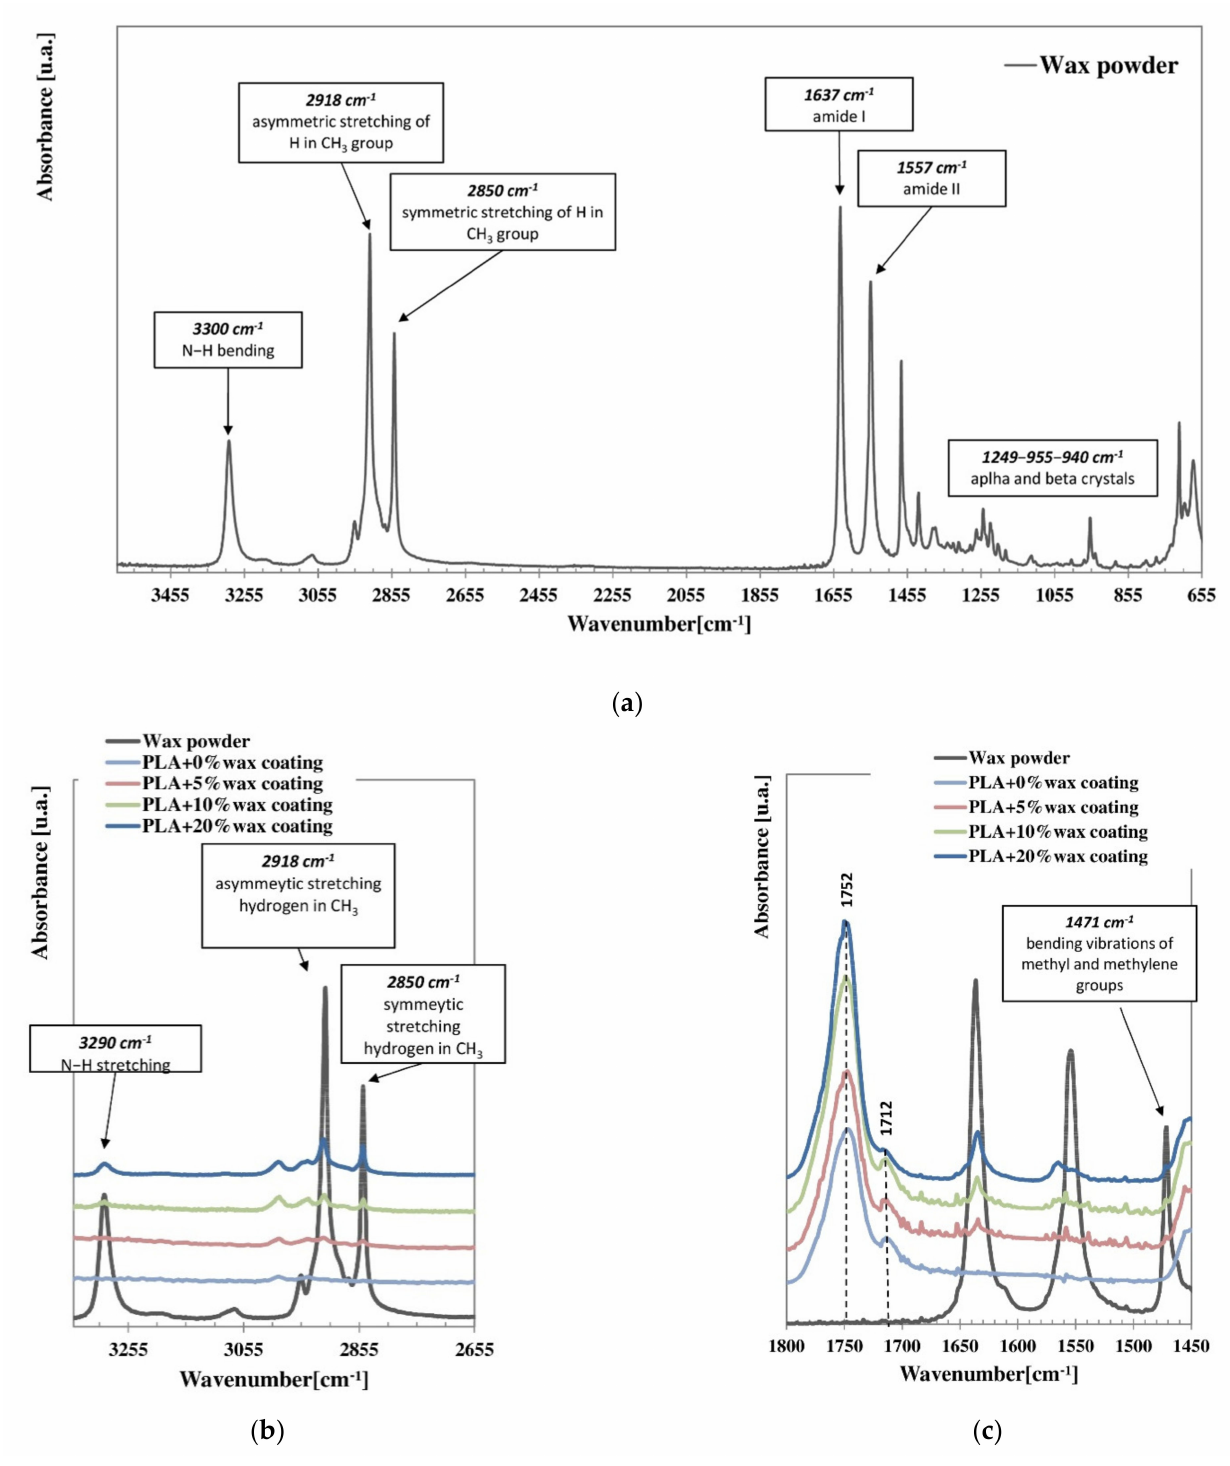
Figure 3. ATR-FTIR spectra of EBS wax ( a ) and of the thin PLA-coating layers loaded at 0, 5, 10 and 20% wax, respectively ( b , c